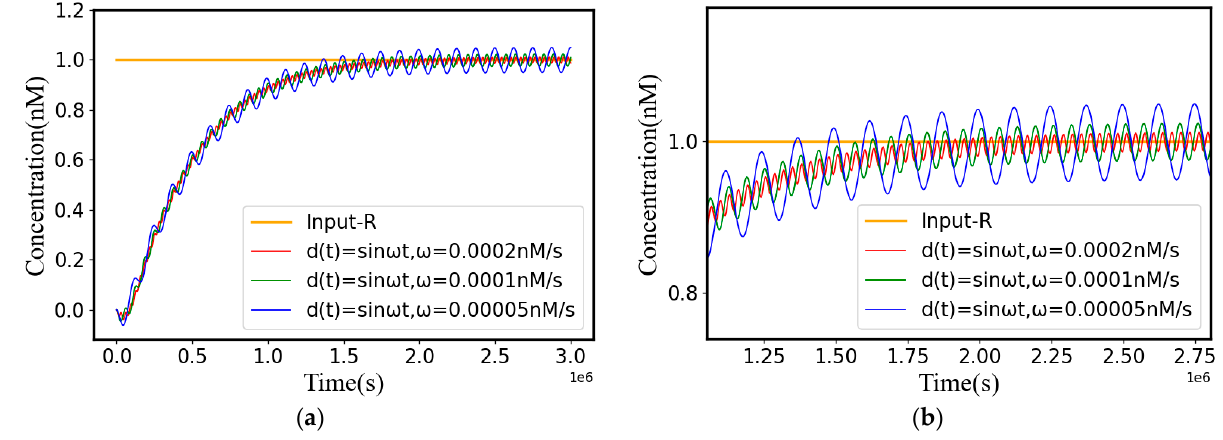
F Figure 10. ( a ) Output response curves of the 2DOF IMC-PID control system F 1 when the disturbance Figure 10. ( a ) Output response curves of the 2DOF IMC-PID control system 1 when the dis- ( ) sin d t t ω= inputs are trigonometric functions d ( t ) = sin ω t with different frequencies. ( b ) The disturbance with different frequencies. ( b ) The dis- turbance inputs are trigonometric functions suppression performance of 2DOF IMC-PID controller. turbance suppression performance of 2DOF IMC-PID controller.